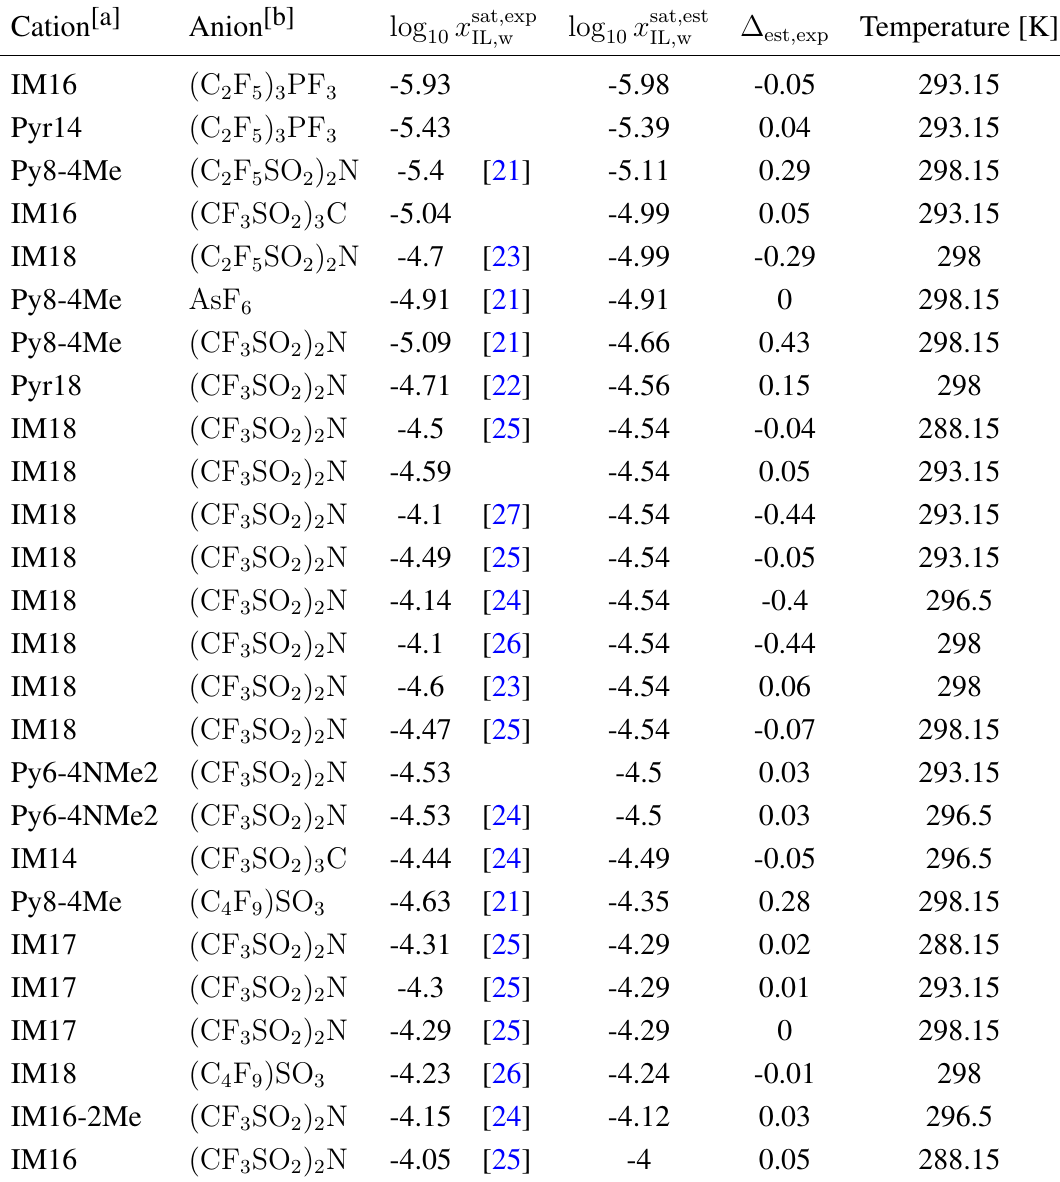
Table 5. Overview of experimental (superscript exp) and estimated (superscript est) water solubility data, sorted by the estimated values. ∆ and observed values on a log scale. The model based on all suitable data was used for the